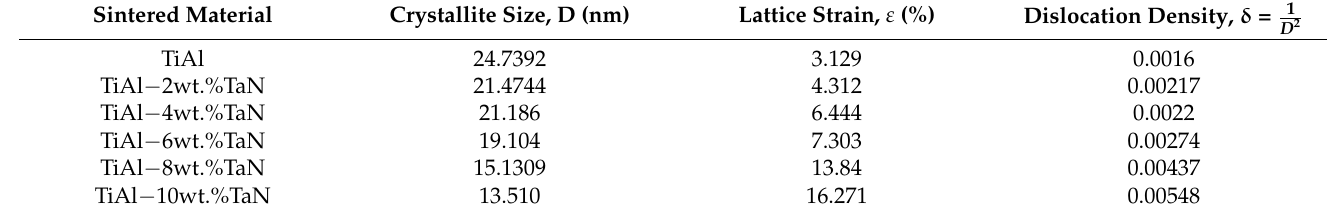
Table 2. Details of the structural parameters of the sintered samples derived from the XRD pattern through the Williamson–Hall approach.